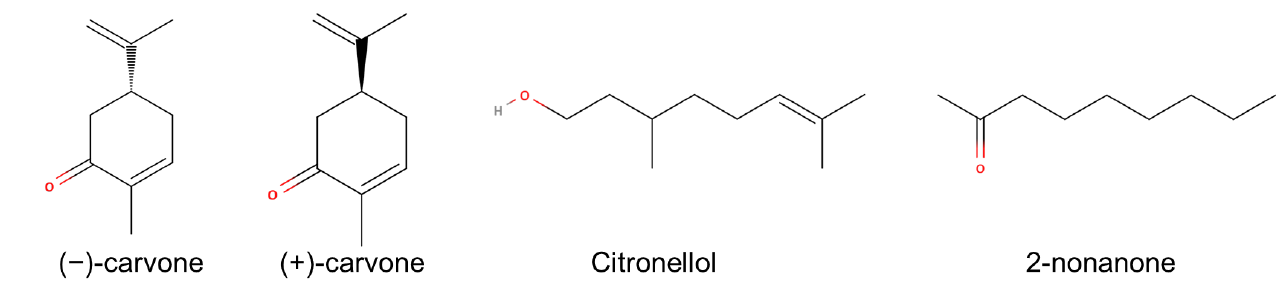
Figure 3. Chemical structure of four agonists of hOR1A1.